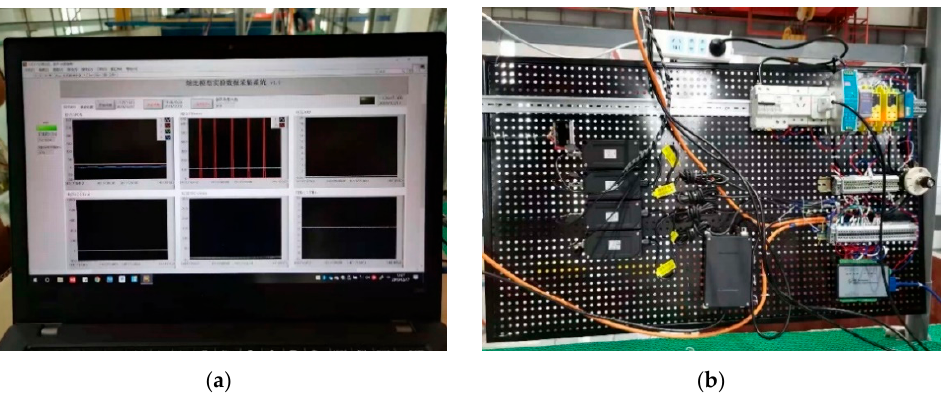
Figure 9. Scaled model data collection system: ( a ) Software Interface; ( b ) Hardware part.